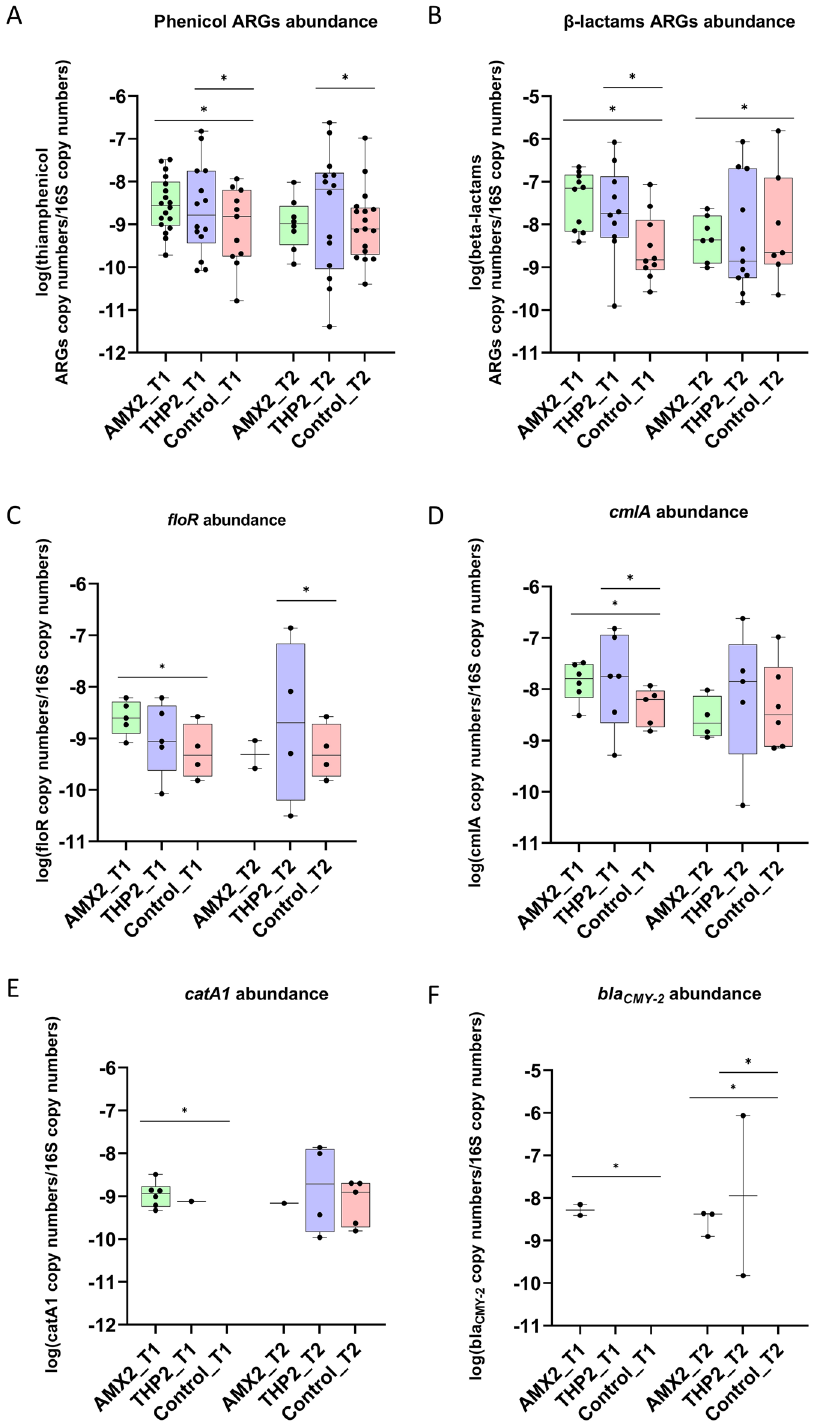
Figure 5. Relative abundance of all genes conferring resistance to β-lactams ( A ) and phenicols ( B ) to 16S rRNA copy number per group per time point after middle-age administration of amoxicillin and thiamphenicol. Relative abundance of genes catA1 ( C ), floR ( D ), cmlA ( E ), and bla CMY-2 ( F ), to 16S rRNA copy number per group per time point. p < 0.05 shown as *. For easiness of representation, only ARGs showing significant differences between groups at the same time point are